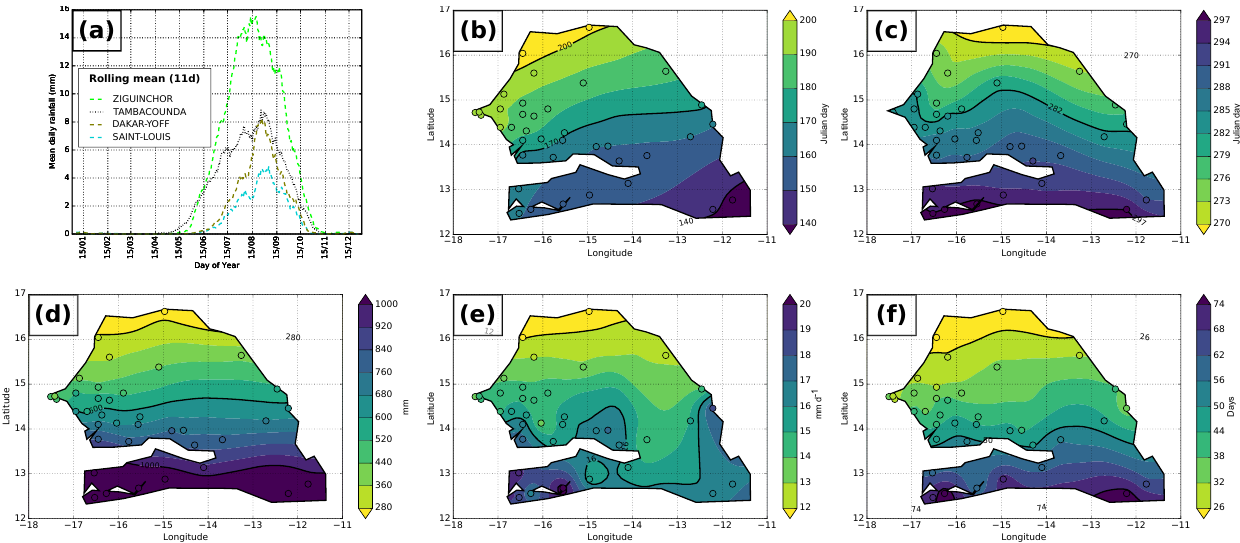
Figure 2. Rainfall regime statistics obtained from daily rain gauges over the 1950–2015 period: (a) mean seasonal cycle at four stations, (b) start of the rainy season, (c) end of the rainy season, (d) mean annual rainfall, (e) mean intensity of wet days, and (f) mean number of wet